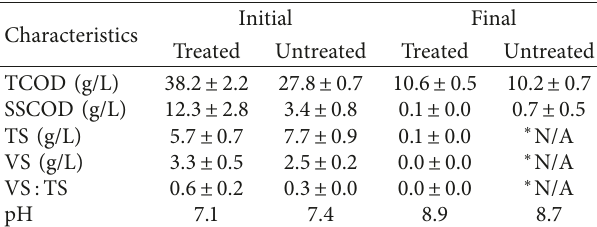
Table 3: Characteristics of starting and ending mixtures of PLA (treated or untreated), food waste, and ADS.